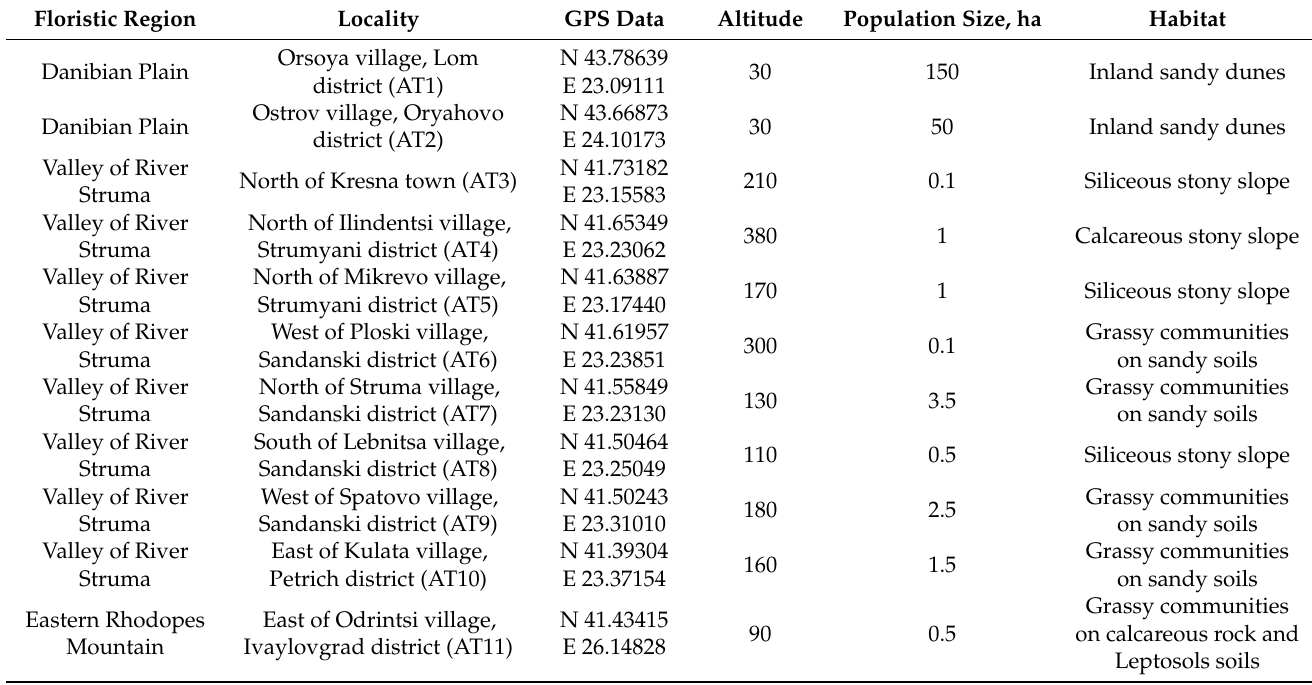
Table 6. List of the studied localities of A. tinctoria in